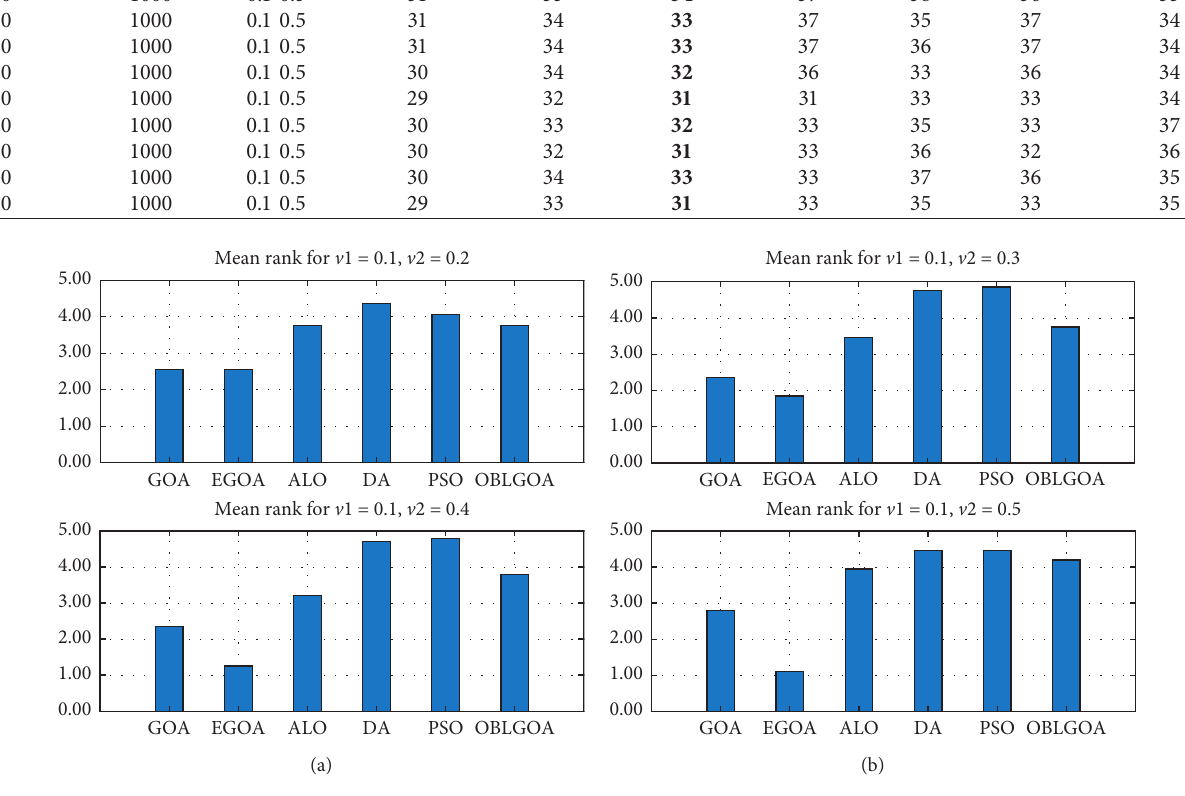
Figure 3: Friedman test for different pair v 1 v